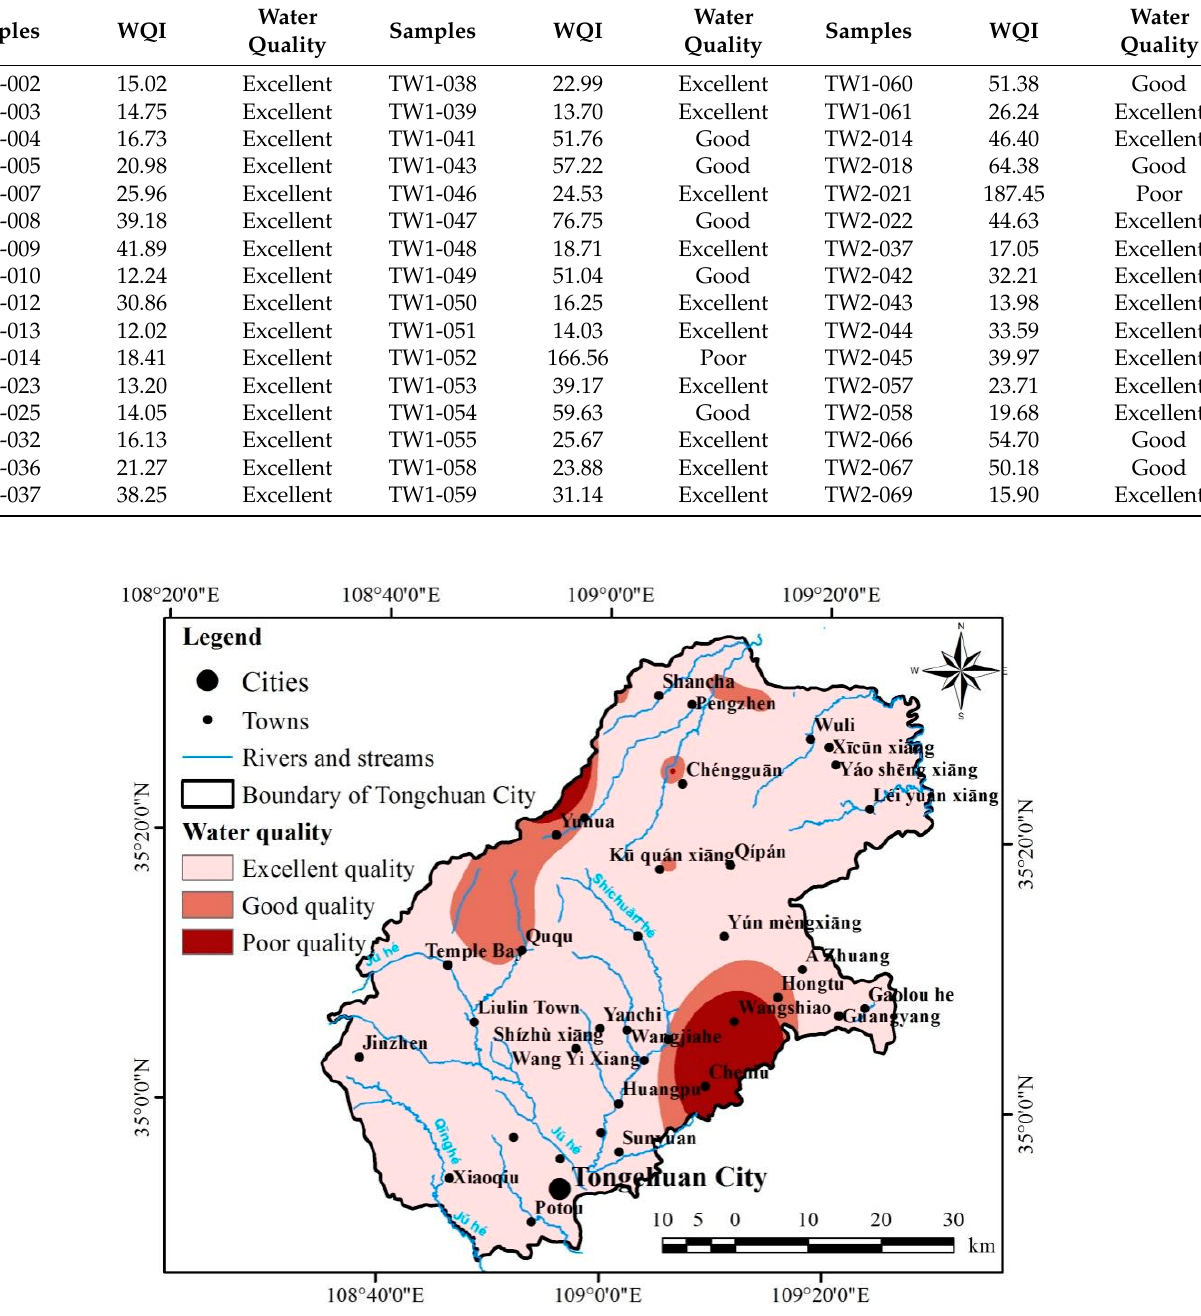
Figure 5. Water quality distribution in Tongchuan City.